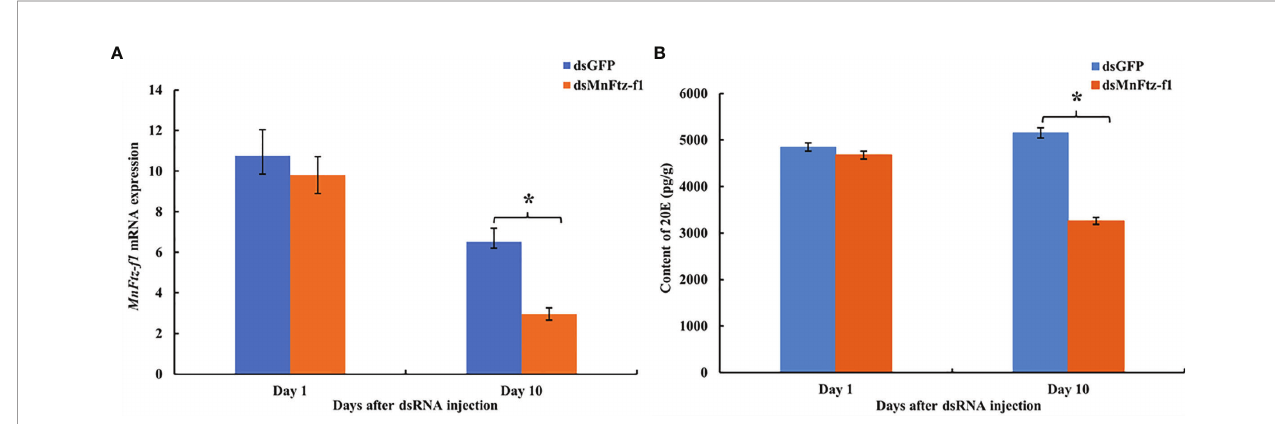
FIGURE 10 | The expression level of Mnftz-f1 (A) and the content of 20E (B) in M. nipponense after RNAi of Mnftz-f1 . Data are expressed as mean ± SEM, and the differences were considered to be signi fi cant at P < 0.05 ( * ) by Student ’ s t -test (n =